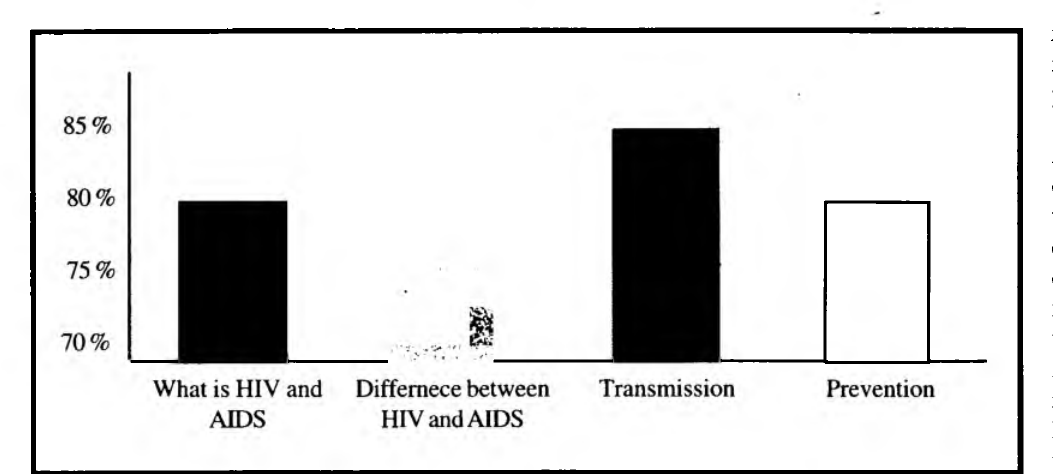
Figure 1 Knowledge of HIV and AIDS basic facts women had undergone — I results of the